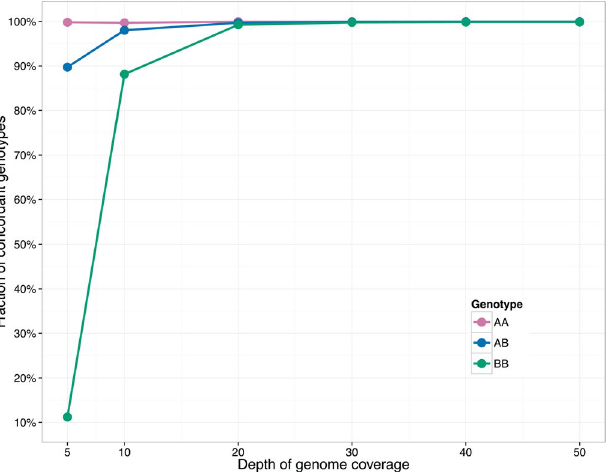
Figure 4. Effect of genome coverage on the concordance of genotypes. The accuracy of calling non-reference variants starts to decline as the genome coverage drops below 20x. Only the accuracy of the non-reference allele (genotypes AB and BB) calls declines significantly as the coverage drops because the higher prior probability of the reference allele has a stronger influence on the final decision of the Bayesian classifier in situations where the coverage is low (which increases the bias toward the more common